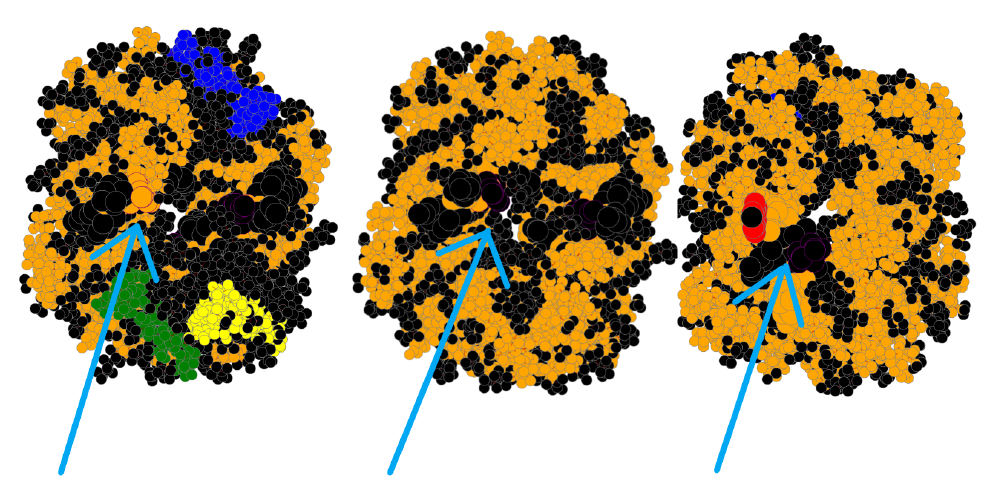
Figure 6. The 3D visualization of the rigid clusters of Deoxy rHb 1.1. ( left to right ) wildtype 1C7C, PDB mutant 1C7D, and the computer-generated mutant. A deletion of Glycine at residue index 143 is modeled. The arrow is drawn to the InDel’s precise location. The 5 largest clusters are colored, while all other clusters are black.